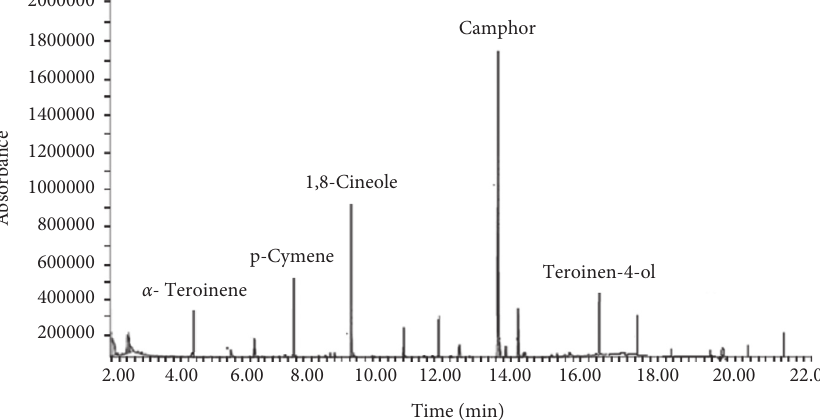
Figure 1: GC-MS analysis of P. cylindraceus